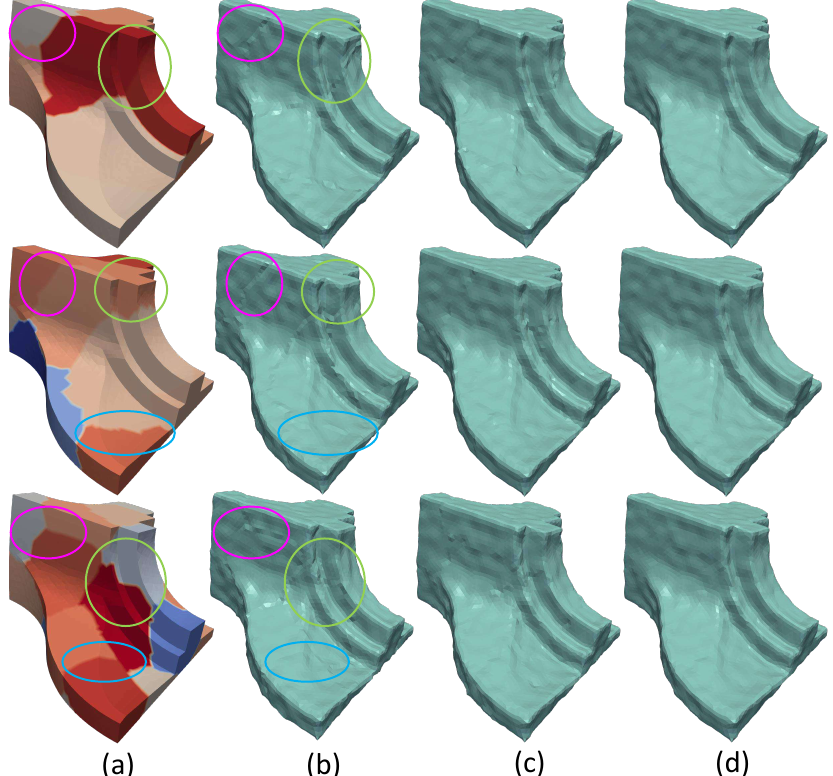
Figure 5. ( a ) The model separated in different number of parts (10, 15 and 20, respectively). Additionally, indicative areas have been selected where two or more submeshes are connected; ( b ) Non Overlapping case, the edge effect is apparent in areas where submeshes are connected; ( c ) Overlapping case, the edge effect have been mitigated but have not been eliminated yet. The bigger the number of the partitioning the more intense the problem of the effect; ( d ) Weighted Overlapping case, the results seem to be independent and unaffected of the partitioning (Fandisk σ 2 =